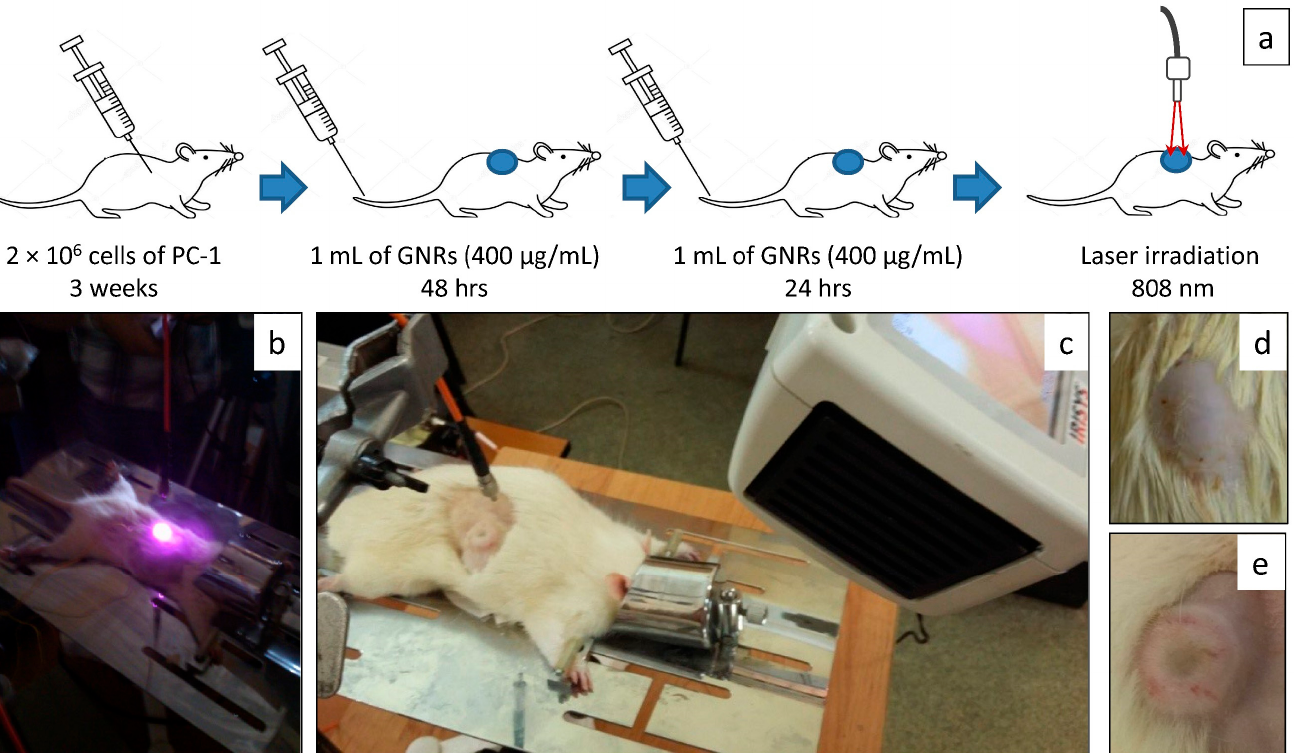
Figure 2. Scheme of experiment ( a ), photos of the experimental setup during PPT ( b ) and just after PPT ( c ), and photos of the tumors from the control group of the rats ( d ) and experimental group after PPT ( e ).